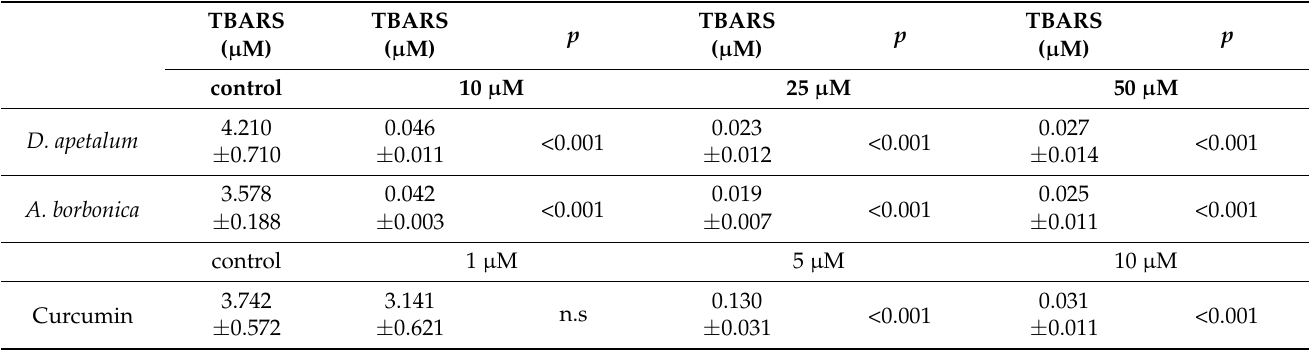
Table 5. D. apetalum and A. borbonica plant extracts prevent lipid